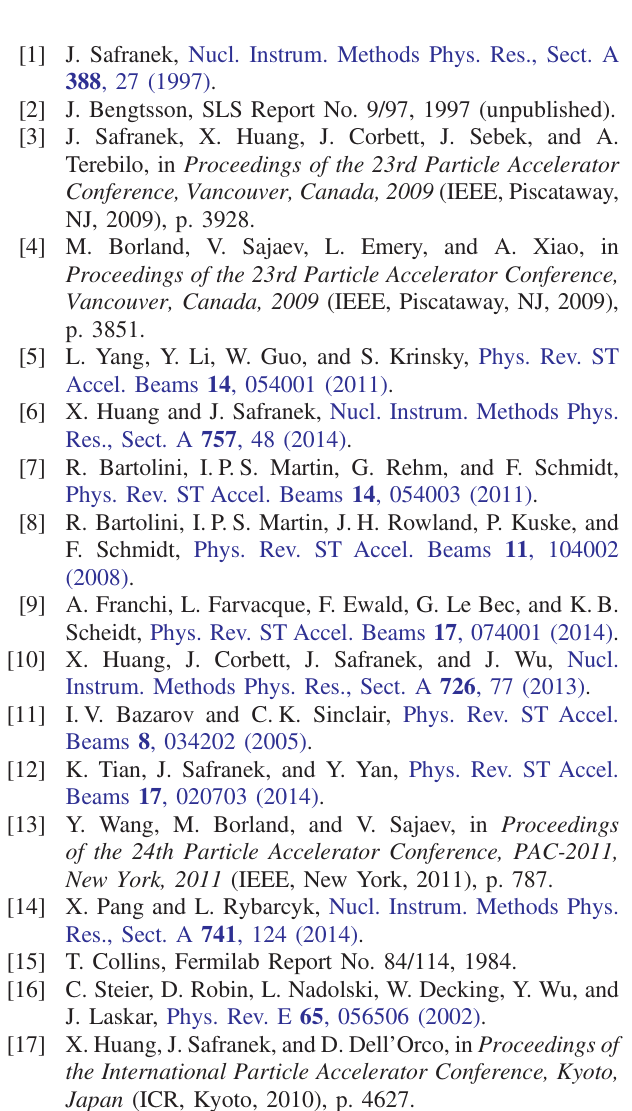
FIG. 6. Dynamic aperture obtained by particle tracking for the original (top) and optimized (bottom)